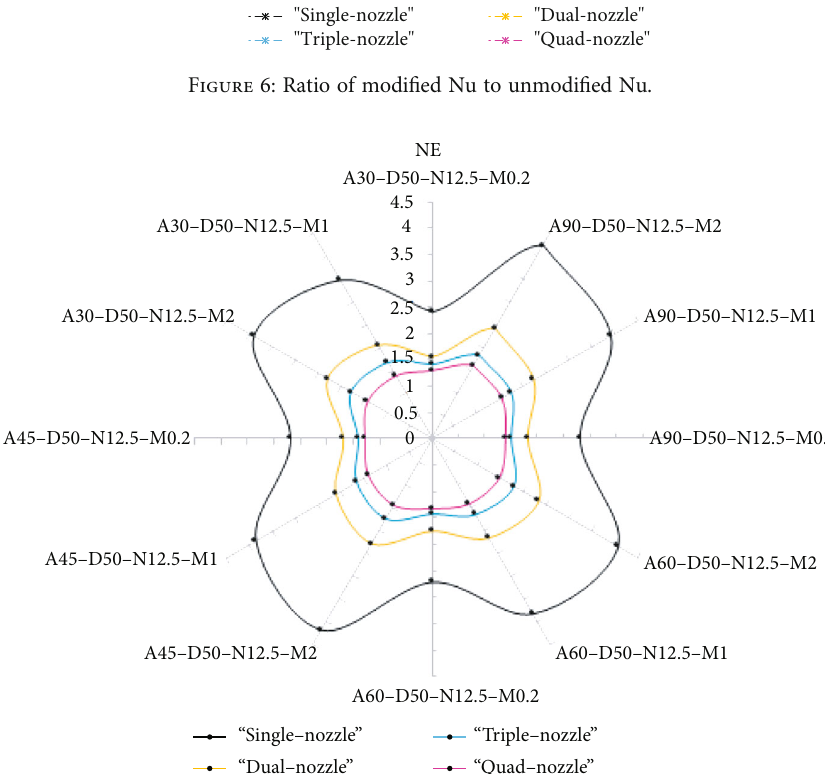
Figure 7: Ratio of modi fi ed N